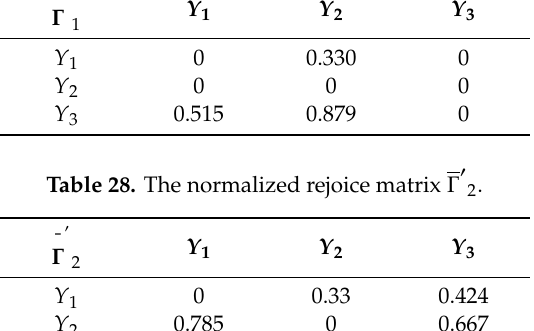
Table 27. The normalized rejoice matrix Γ